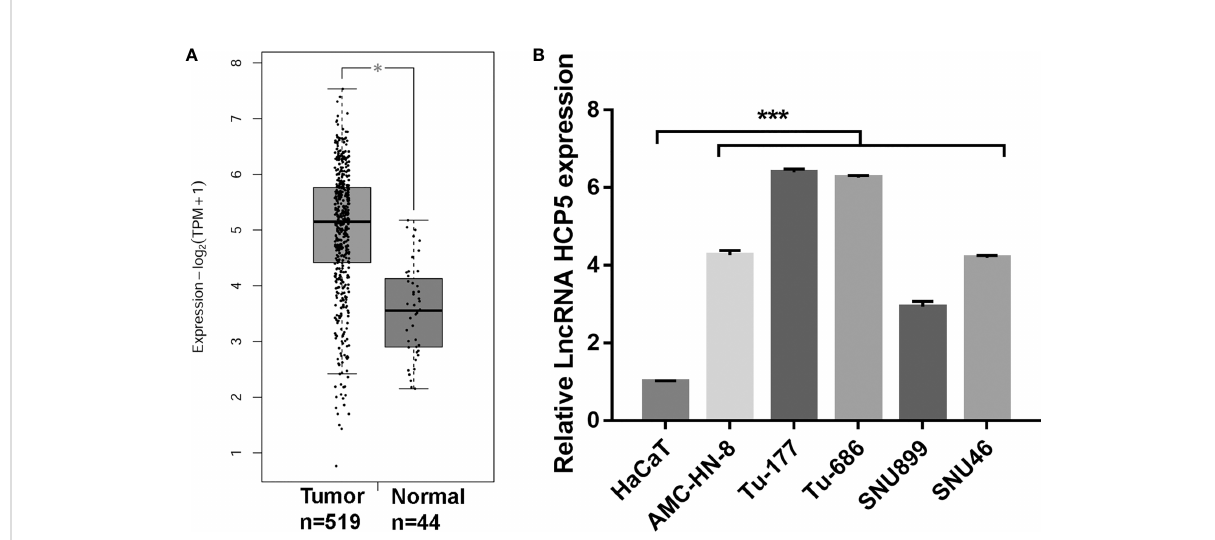
FIGURE 1 HCP5 expression was prominently raised in head and neck squamous cell carcinoma tissues and LSCC cell lines. (A) HCP5 expression in normal and tumor tissues was analyzed by GEPIA *P < 0.05. (B) HCP5 expression was measured by RT-qPCR in LSCC cell lines including Tu-177, Tu-686,